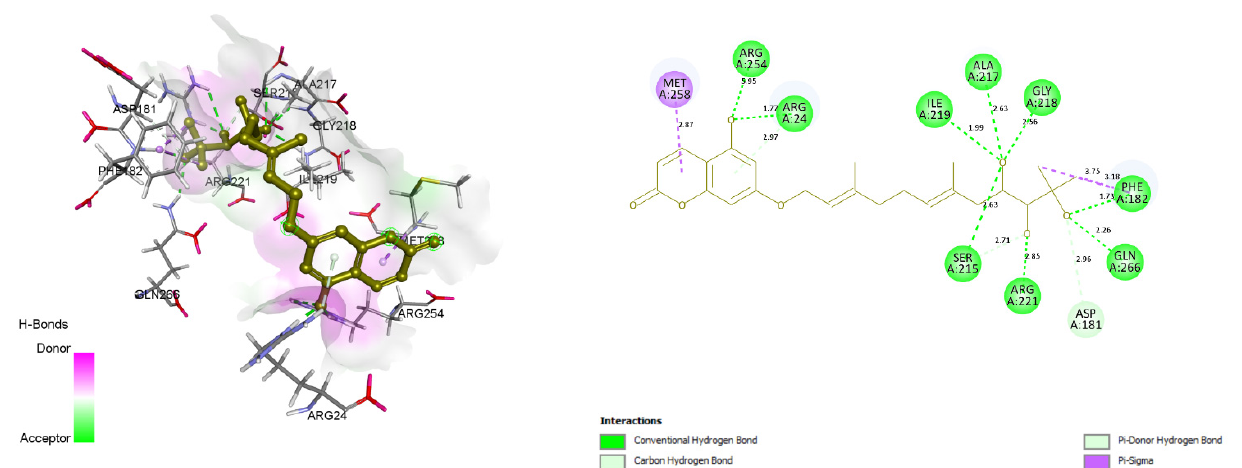
Figure 7. Docking view of ZINC31168048 in the binding sites of PTP1B (PDB ID: 1AAX). On the left side is the stereo view of the docked complex-ZINC31168048 and 1AAX, and on the right side ZINC31168048 -1AAX interactions are presented in 2D. Diagrams are drawn in Discovery Studio, hydrogen-bonds are shown as a green-dashed line along with the distance in Å. Protein structure residues are annotated with a 3-letter amino acid code, while ZINC31168048 is presented in agreen-colored ball and stick style.